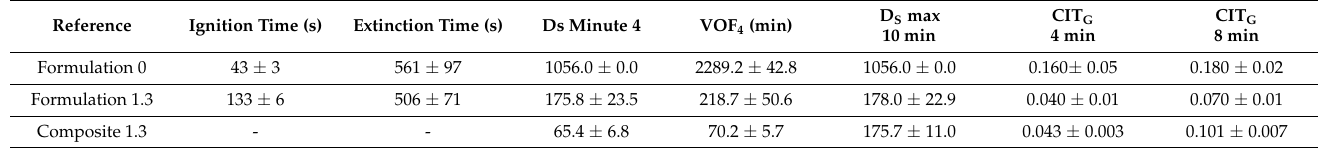
Table 7. Smoke density and gas toxicity results of resin formulations (casts) and composite *.